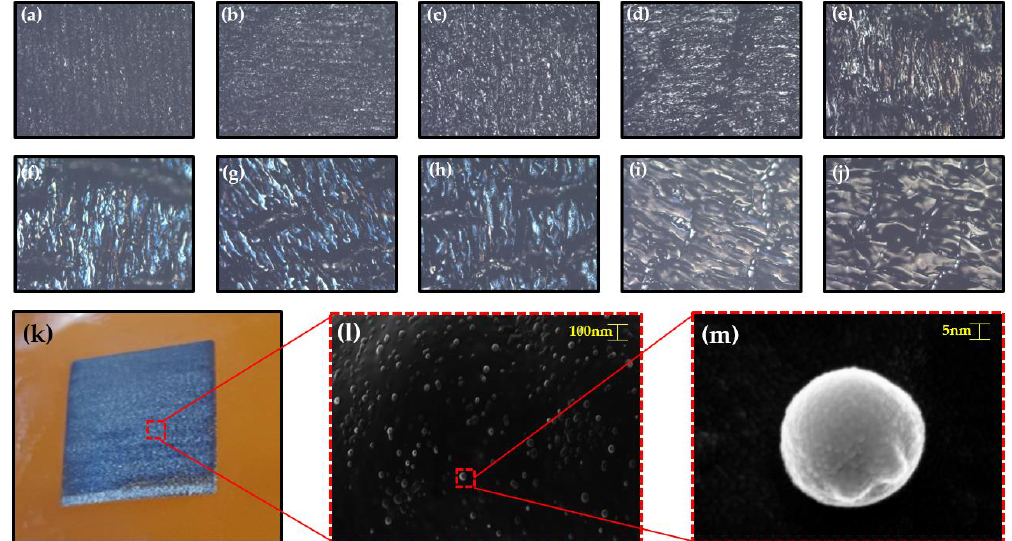
Figure 9. ( a – j ) Optical microscope images of patterns fabricated at intervals of 1, from +3 to −7, ( k ) an actual photo of the structural blue color of patterns fabricated at a laser speed of 20 mm/s, ( l ) an FE-SEM image of the patterns, and (m) an FE-SEM image of a nanosphere with scattering.